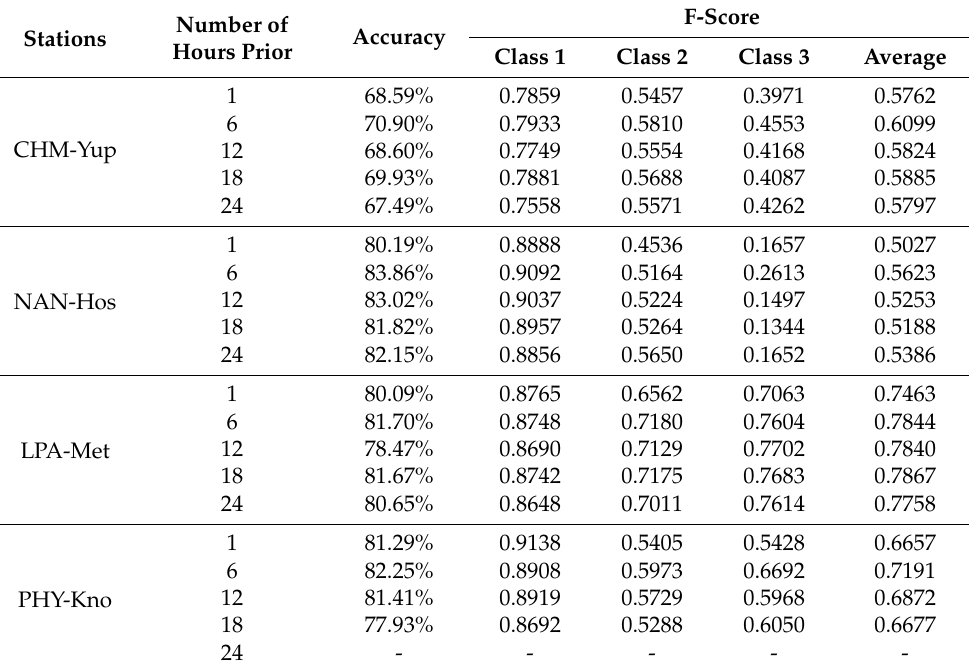
Table 3. Model performance of the transformed dataset with different amounts of historical data to predict hourly PM 10 with the three classes of output data.